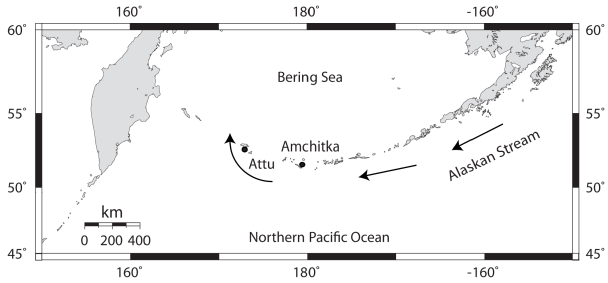
Fig. 1. Location of sample collection sites offshore of Attu and Amchitka Islands along the Aleutian Arc in the northern North Pa- cific Ocean and Bering Sea. Black circle indicates sample locations. (Map generated at